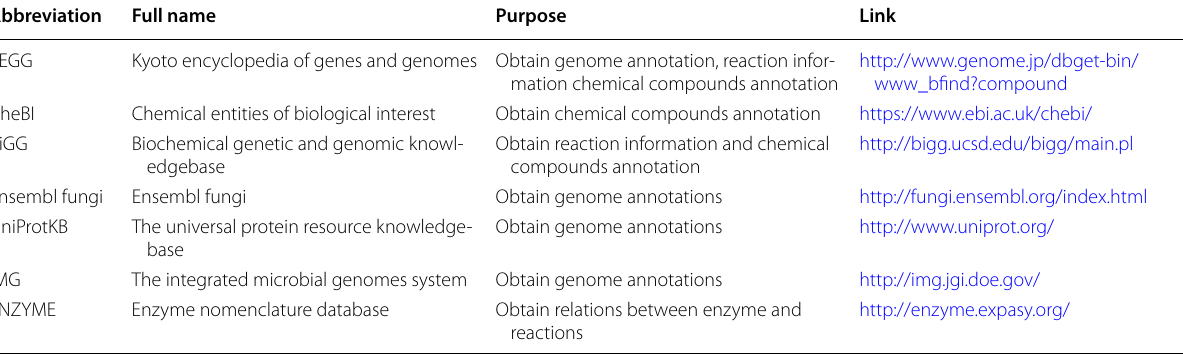
Table 1 Information of databases used in this